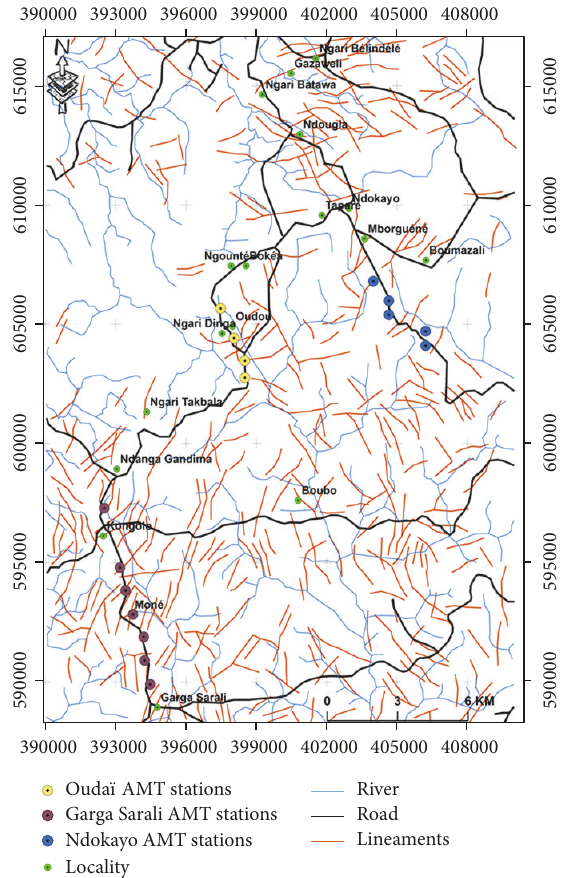
Figure 4: Foliation (minor lineaments) of the study area (repro- duced and modified from Noutchogwe et al., 2011, under the public